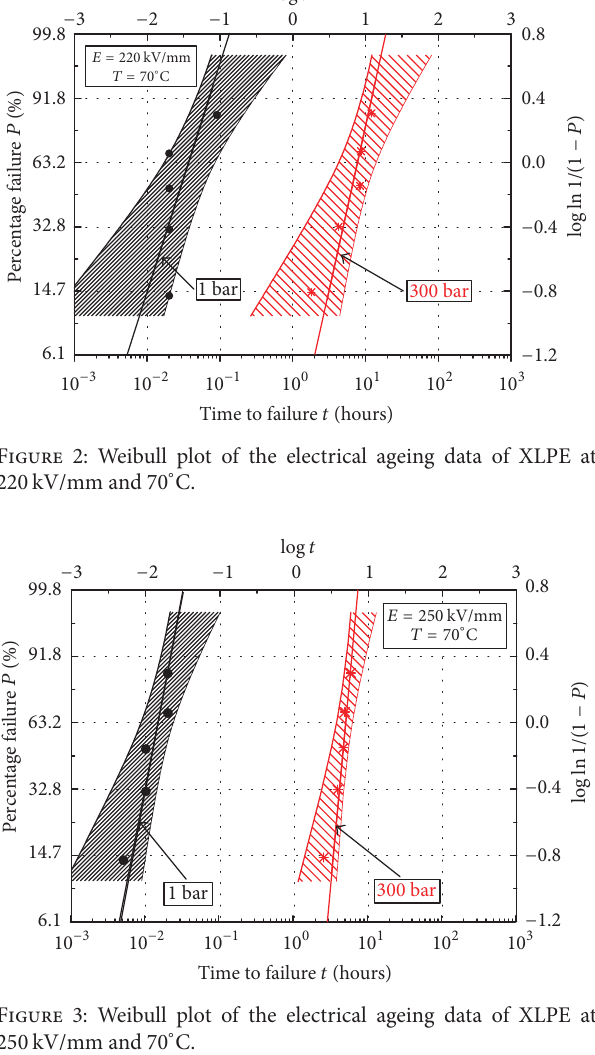
Figure 3: Weibull plot of the electrical ageing data of XLPE at 250 kV/mm and 70 ∘ C.